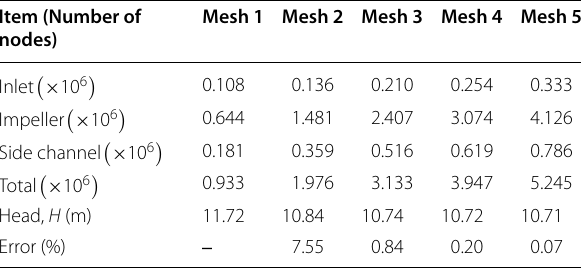
Table 3 Mesh independence study Item (Number of nodes)